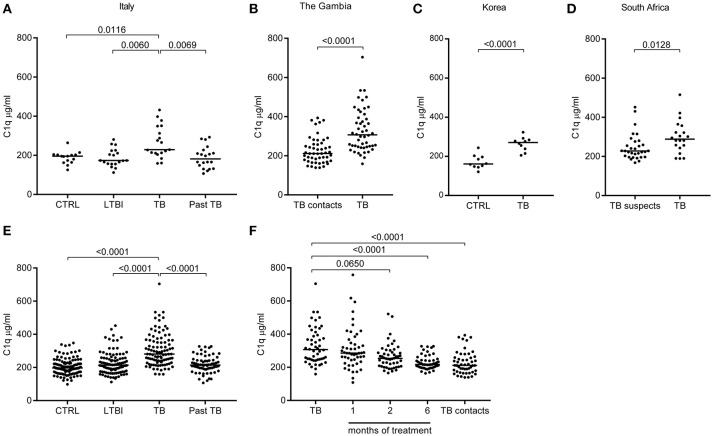
C1q serum levels are increased in patients with pulmonary Tuberculosis. C1q levels (μg/ml) were measured with ELISA in sera from TB patients (active disease) and controls from different cohorts. First the results from the independent and geographically different cohorts are depicted. TB patients from Italy were compared to Latent TB infected (LTBI), to Past TB (patients that were successfully treated for TB) and to endemic controls (A). TB patients from The Gambia were compared to TB contacts (B). TB patients from Korea were compared to endemic controls (C). From South Africa the TB patients were compared to patients suspected for TB but confirmed non-TB (D). Subsequently, data from the cohorts were pooled: control (CTRL) comprises Dutch healthy controls, combined with the CTRL from Italy and Korea; moreover, healthy individuals prior to vaccination with BCG were included (n = 117). Latent TB infected (LTBI) comprises LTBI from Italy, TB suspects (confirmed non-TB) from South Africa and TB contacts from the Gambia (n = 100). Active tuberculosis (TB) from Italy, the Gambia, Korea and South Africa (n = 99); Past TB are patients that were successfully treated for TB and combined the past TB from Italy and the Gambia samples after 6 months of treatment (n = 71) (E). From the Gambia the TB patients were followed over time during treatment, TB contacts are shown on the right (n = 50) (F). Results were analyzed using the Mann-Whitney U test, >2 groups Kruskall-Wallis and Dunn's multiple comparisons test. The treatment months were compared to TB diagnosis with Friedman Test and Dunn's multiple comparisons test.